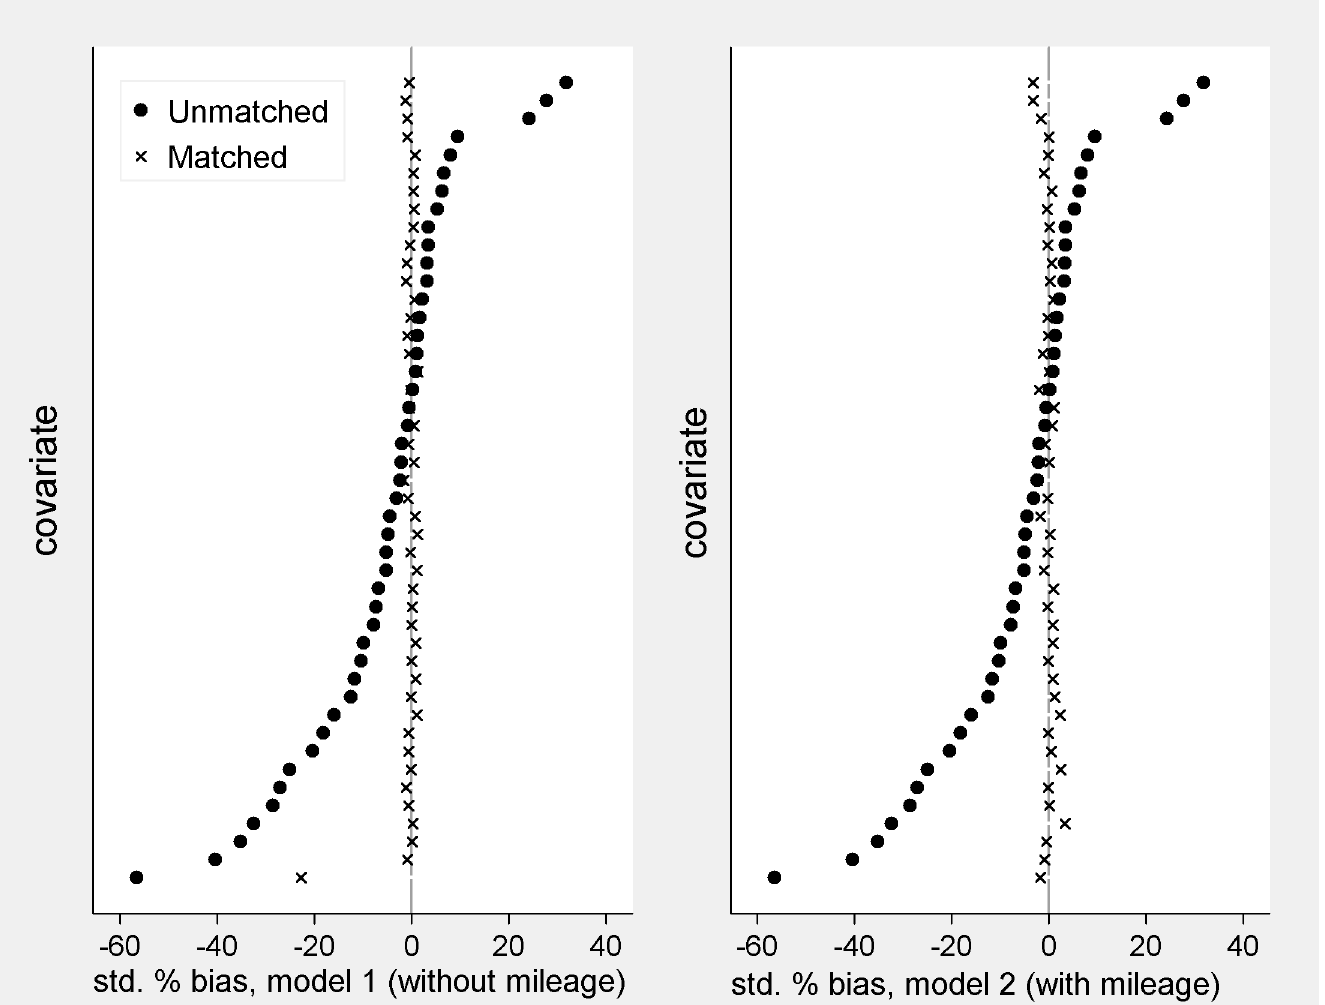
Fig 4. Standardised percentage bias between covariates in Z = 0 and Z = 1 households. Notes. 1. Covariatesare those shown in Fig 2, less square and interaction terms, plus topcodedummies. 2. The mean, medianand maximum absolute standardised % bias are 1.1, 0.6 and 22.7 for model 1 and 1.0, 0.7 and 3.3 for model